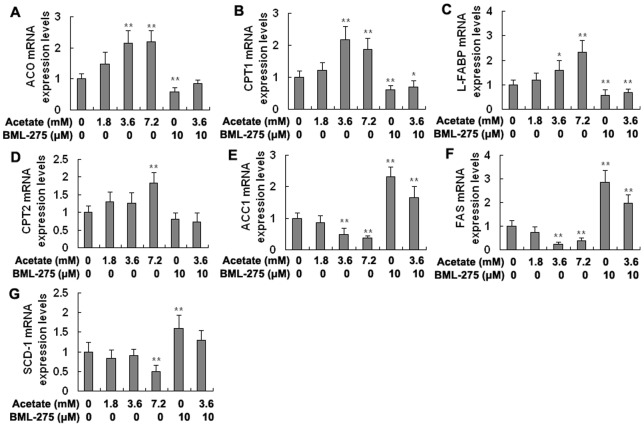
The mRNA expression levels of PPARα, SREBP-1c, and ChREBP target genes in hepatocytes.Hepatocytes were treated with acetate and BML-275 and divided into a control group (0 mM acetate), a low-dose acetate treatment group (1.8 mM acetate), a medium-dose acetate treatment group (3.6 mM acetate), a high-dose acetate treatment group (7.2 mM acetate), a BML-275 group (10 μM BML-275), and a BML-275+acetate group (10 μM BML-275+3.6 mM acetate). Acetate (sodium acetate) was used in the form of neutralized acetic acid to avoid changing the pH of the medium. A-D: mRNA expression levels of ACO, CPT1, L-FABP, and CPT2, respectively. E-G: mRNA expression levels of ACC1, FAS, and SCD-1, respectively. * p<0.05, ** p<0.01 versus the control group.